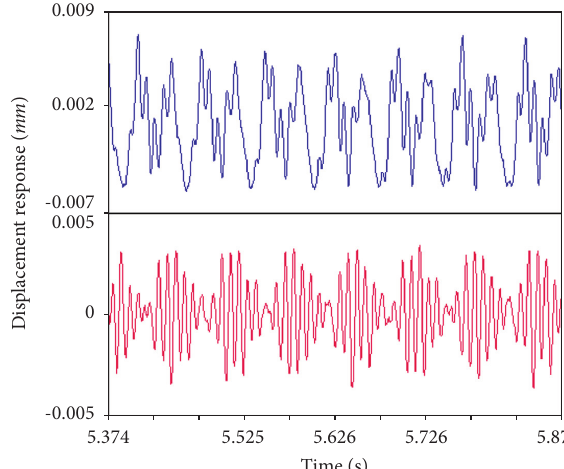
Figure 29: Comparison of response stability.